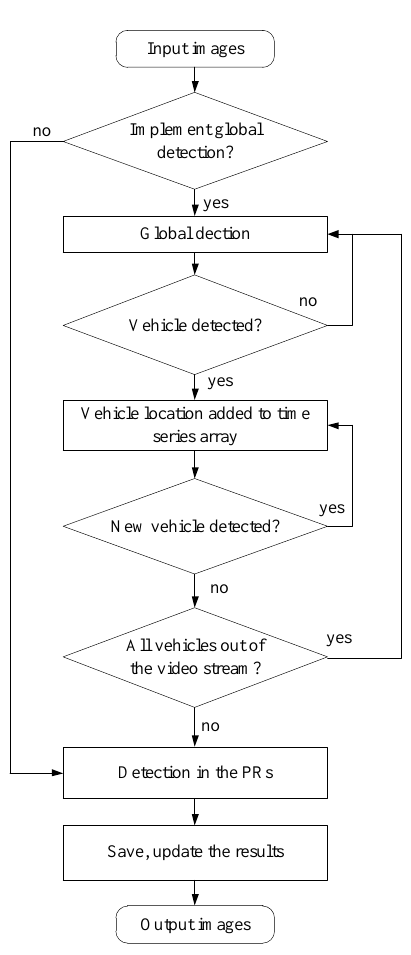
Figure 4. The flow